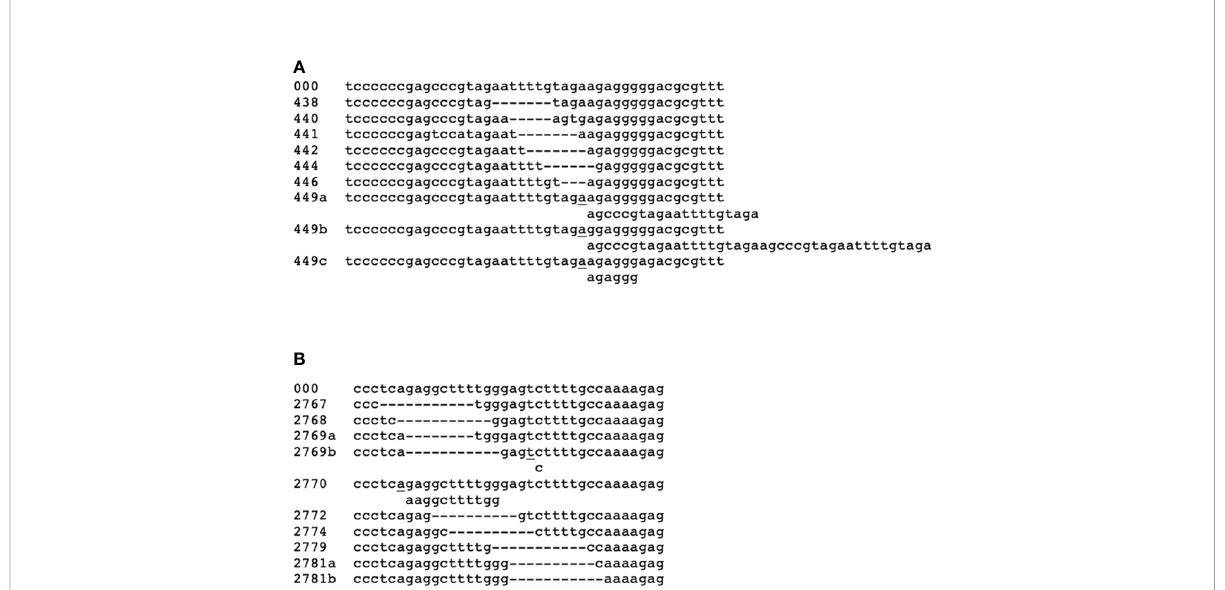
FIGURE 3 Structures of two variable CaTA regions. (A) Region around G240-CaTA coordinates 438-449, showing 6 different types of deletion, the region starting from 449 shows three types of insertion. (B) Region around 2767-2781. 10 different deletions and one insertion were found in this region. Coordinates on the left indicate the positions after which the sequence diverges from the standard sequence, the latter indicated by 000. Insertions are shown below the normal sequence and start behind the underlined nucleotide. See also Table 1 and Supplementary Table